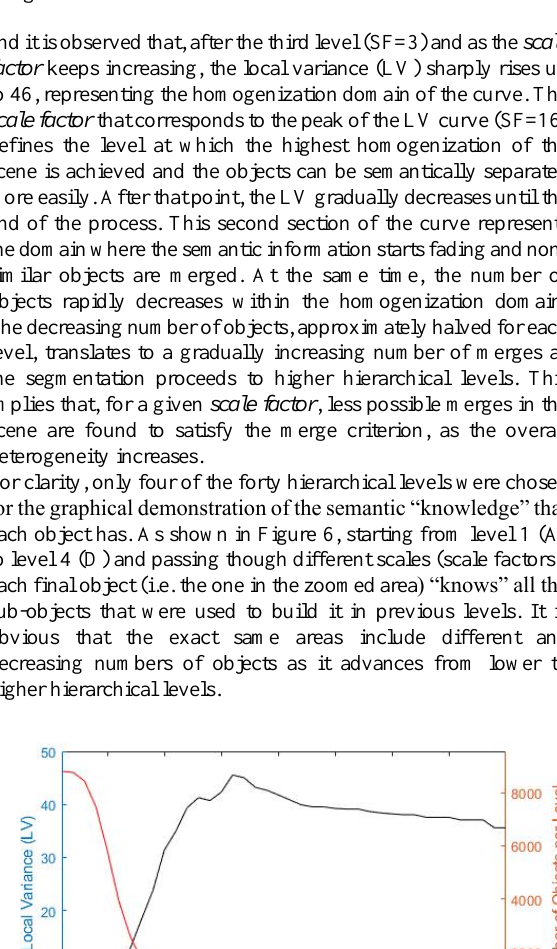
Figure 4. Over- and under-segmentation example for the same voxel size. A) 3D point cloud of the study area with the spires and rock exposures within the main channel enclosed by red and cyan line, respectively, B) segmentation result with SF=5, C) segmentation result with SF=16, and D) segmentation result with